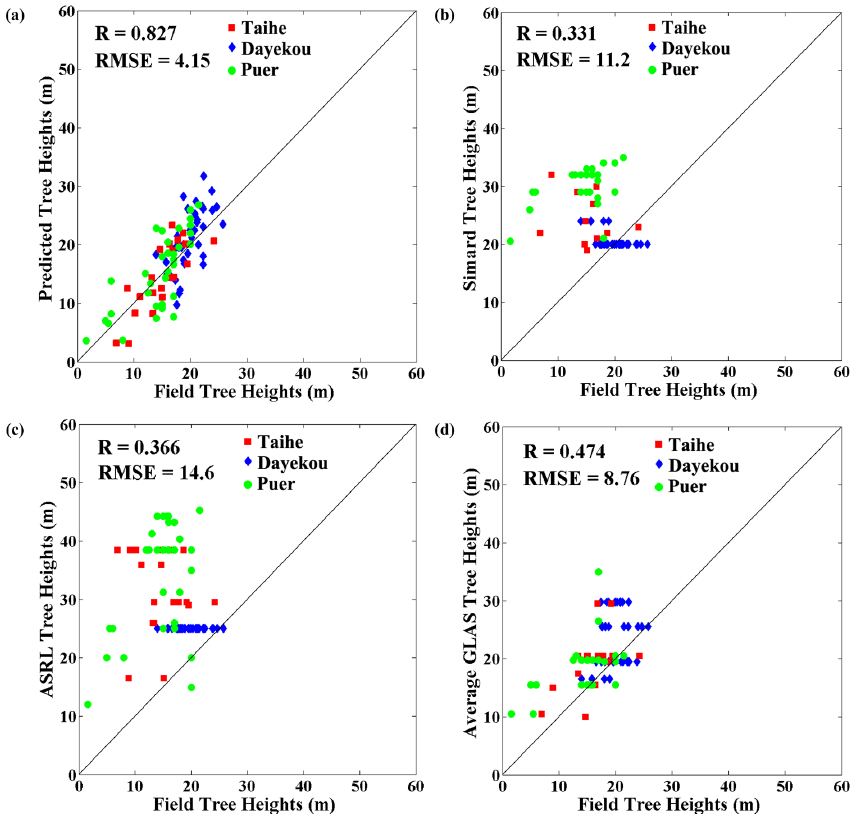
Figure 4. Ground validation result of the modeled tree heights, H Simrad , H Ni and GLAS tree height map. ( a ) The comparison between modeled tree heights and field measured tree heights; ( b ) The comparison between H Simrad and field measured tree heights; ( c ) The comparison between H Ni and field measured tree heights; ( d ) The comparison between averaged GLAS tree heights and field measured tree